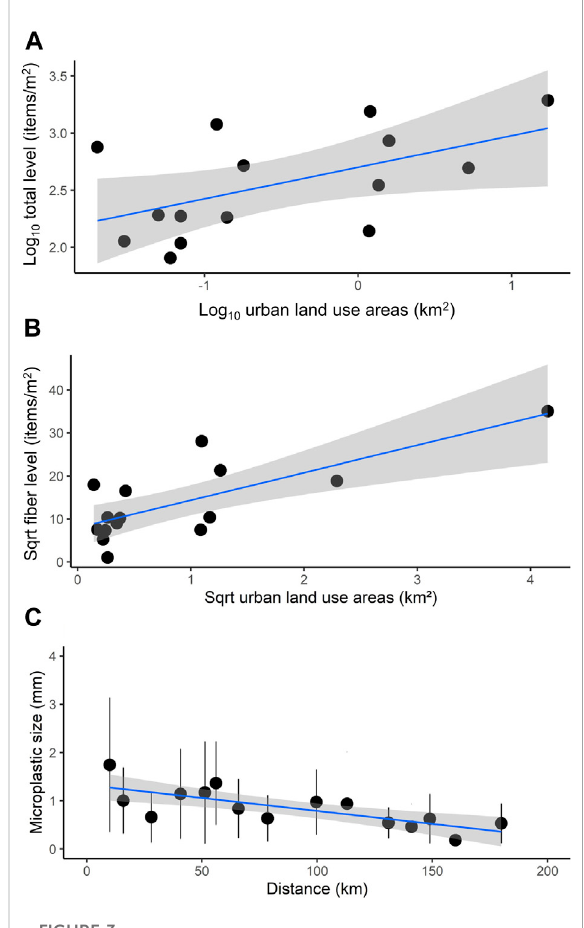
FIGURE 3 Statistically signi fi cant microplastics relationships with environmental variables. (A) Microplastic level in function of urban landuseareas -log 10 transformation ( fi gure a) R 2 =0.29 ( p =0.03). (B) Fiber level in function of urban land use areas - sqrt transformation( fi gureb) R 2 =0.56( p =0.001). (C) Microplasticsize in relation to the distance from the Metropolitan region ( fi gure c) R 2 = 0.55 ( p = 0.001). Urban land use areas are from Supplementary Table S1 (see Sampling Sites in Materials and